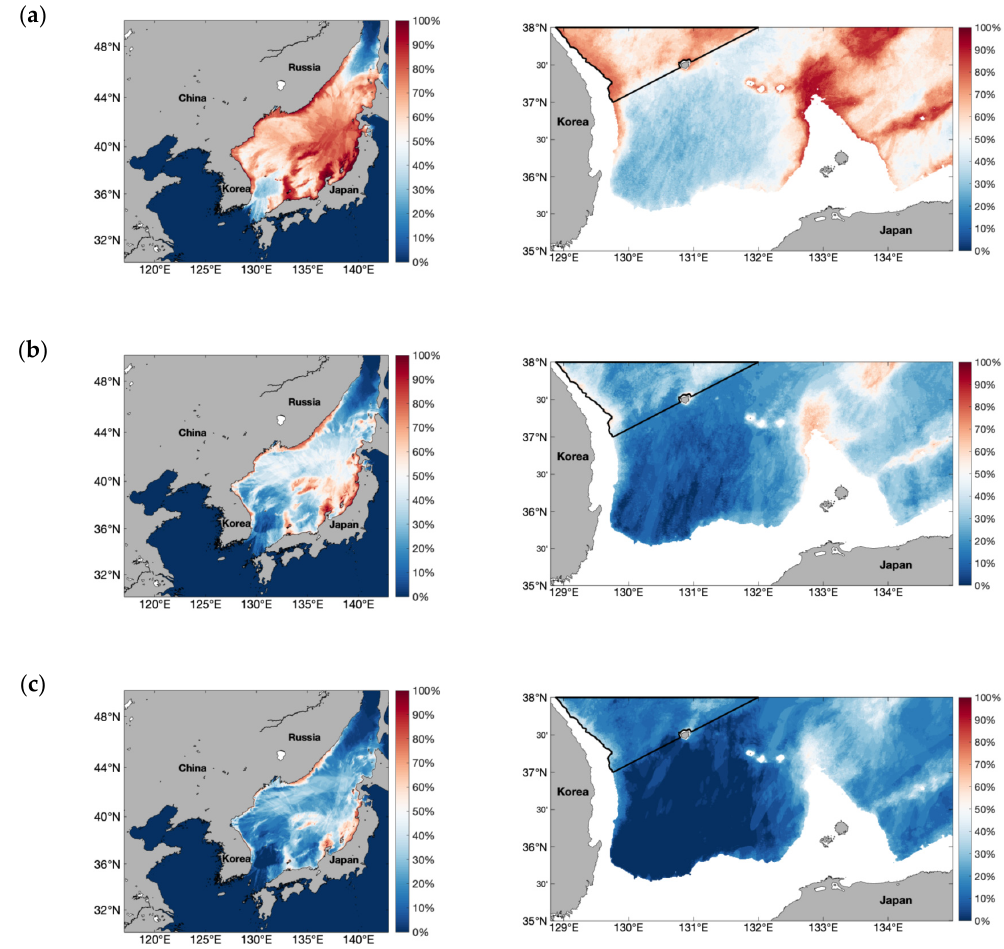
Figure 6. MLE results for maximum tsunami wave height distribution from COMCOT numerical modeling of 39 potential tsunami scenarios. Probability results for ( a ) 0.1 m ( b ) 0.2 m and ( c ) 0.3 m maximum height tsunami wave. The left side displays the results in the entire numerical model domain, and the right side displays the results in the eastern sea of Korea in water depth greater than 300 m. The black line indicates the higher tsunami detection probability boundary.